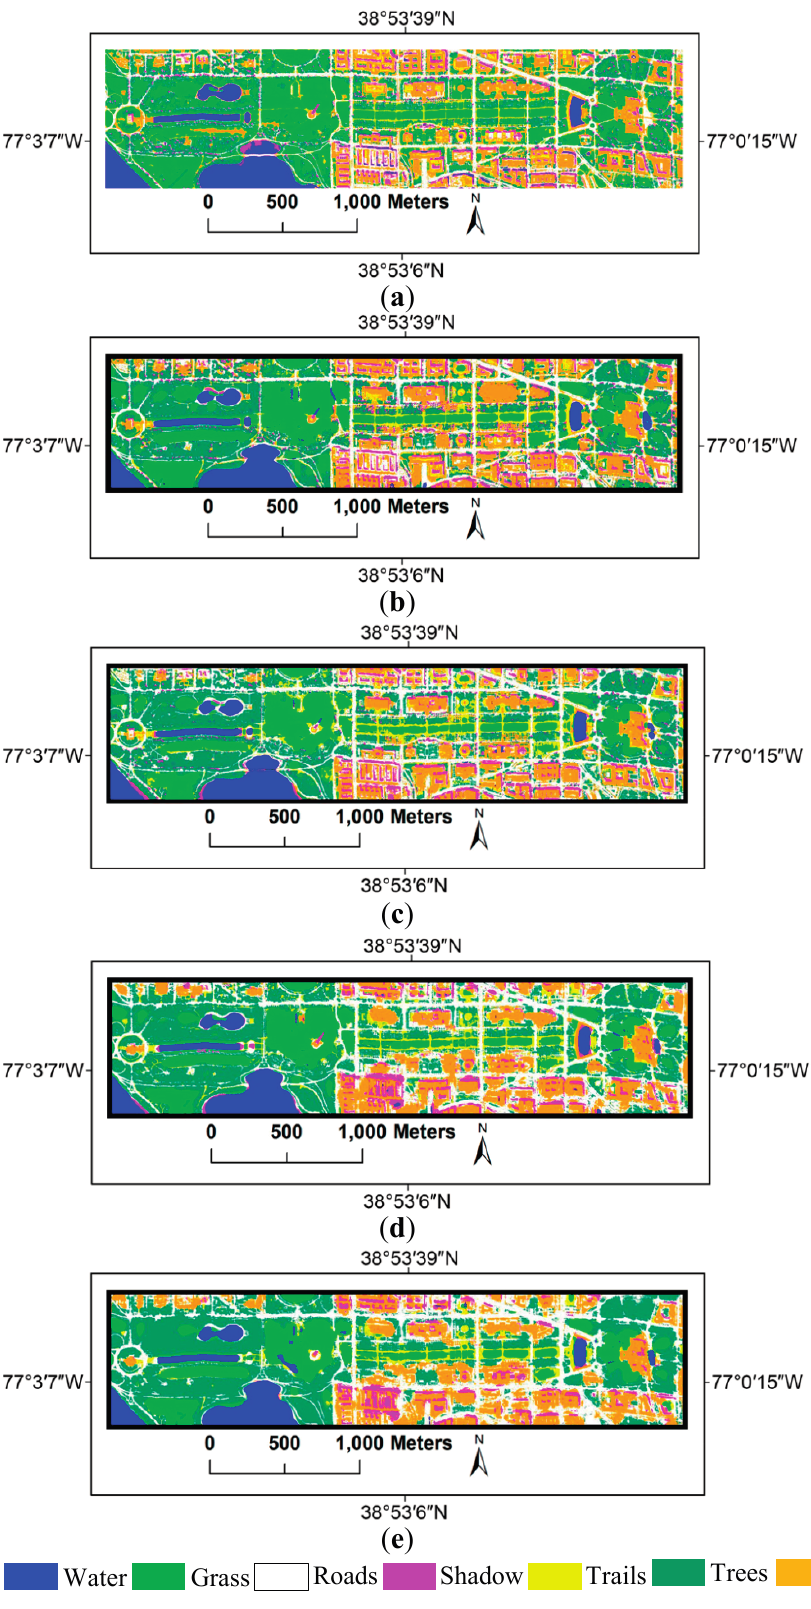
Figure 9. SVM classification results of the HYDICE DC Mall by ( a ) the original hyperspectral bands; ( b ) PCA-GLCM with a quantization level of 64; ( c ) K-means GLCM with a quantization level of 32; ( d ) S-GLCM (2) with a quantization level of 8; ( e ) C&S-GLCM with a quantization level of